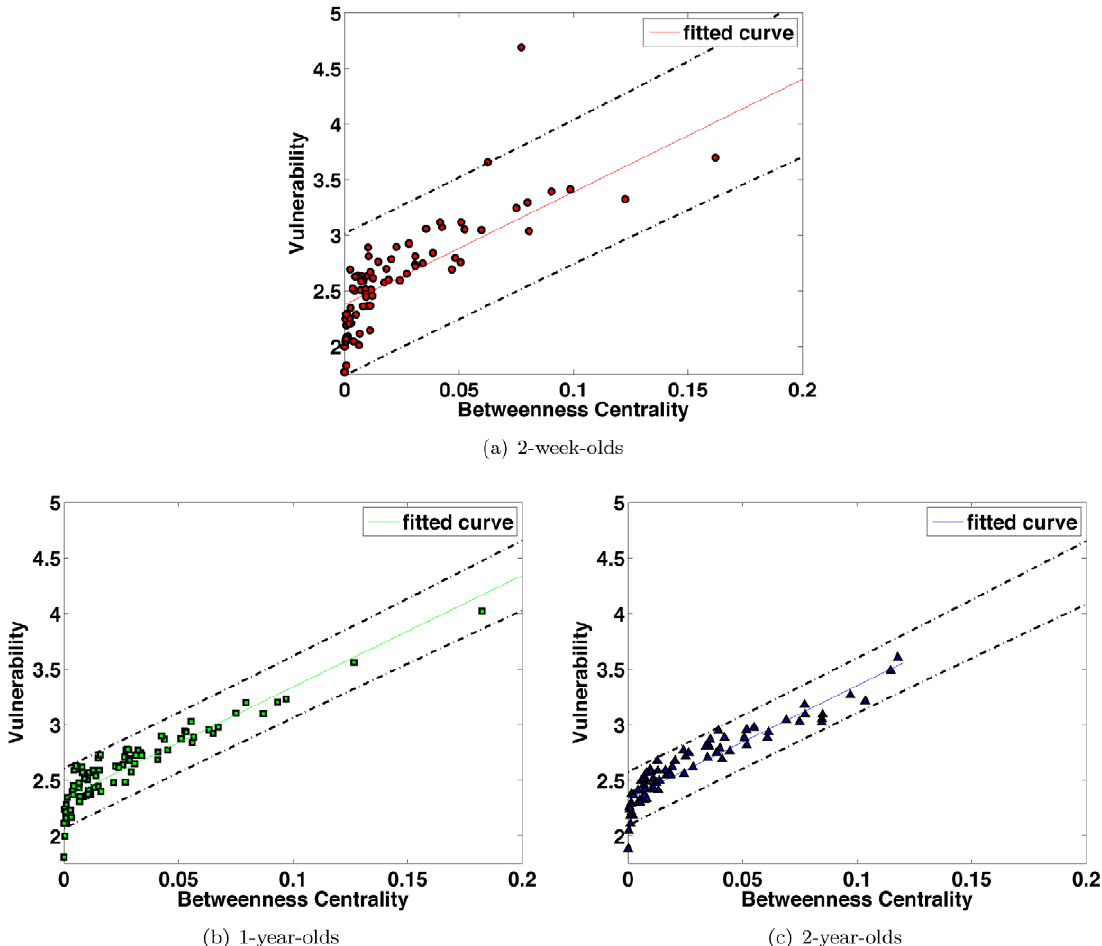
Figure 10. Betweenness Centrality and Vulnerability. Removal of a node with high betweenness generally results in a significant disruption of information flow in the brain network as indicated by a higher vulnerability value. The dashed lines indicate 95% confidence interval. The betweenness centrality value is normalized by division by the total number of possible connections (78 { 1)(78 { 2) = 2 ~ 3003 .